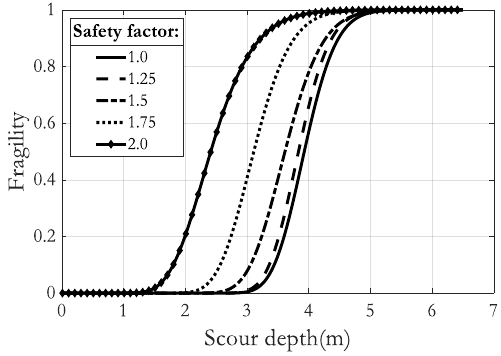
Figure 16. Scour fragility curve. Table 2. Median and log-standard deviation.